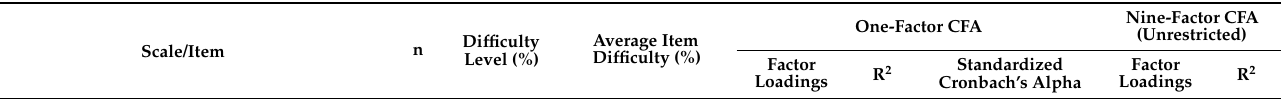
Table 2. Difficulty level and psychometric properties of English HLQ among students in Nepal (Part 2, Scales 6 – 9